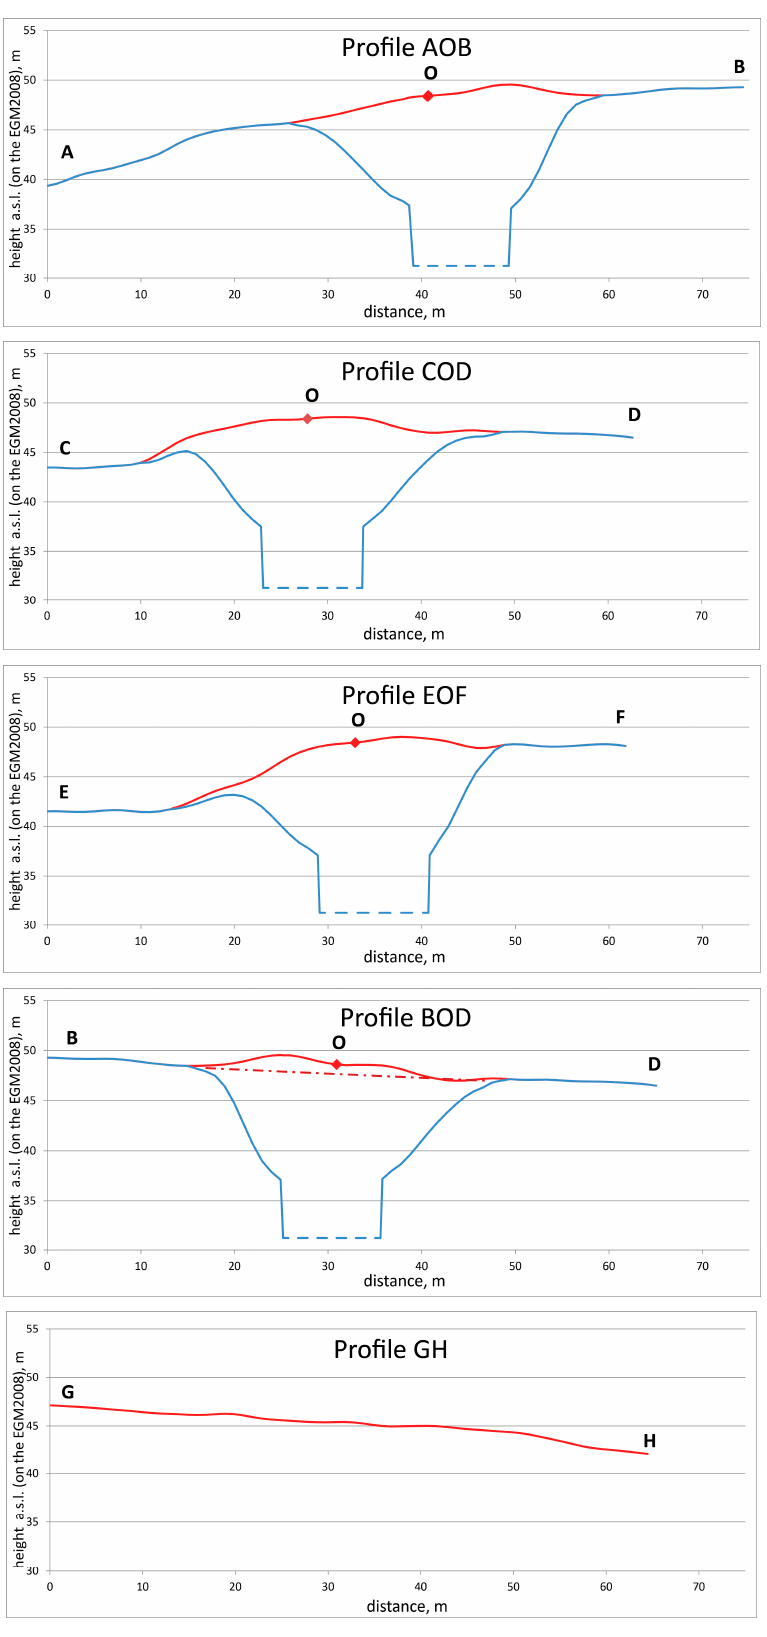
Figure 6. Morphometric characteristics of AntGEC. Hypsometric profiles: red line as of 21 August 2013, blue line as of 11 October 2014. The bottom of the crater was not detected with the DEM comparison.